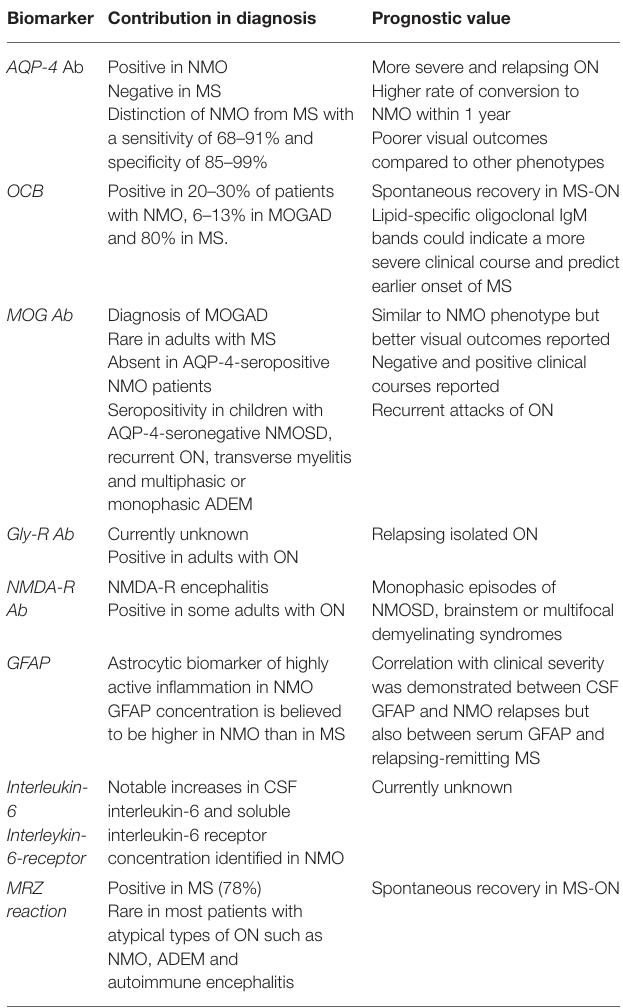
TABLE 4 | Biomarkers with prognostic value in people with ON (72, 81, 112, 118–139). Biomarker Contribution in diagnosis Prognostic